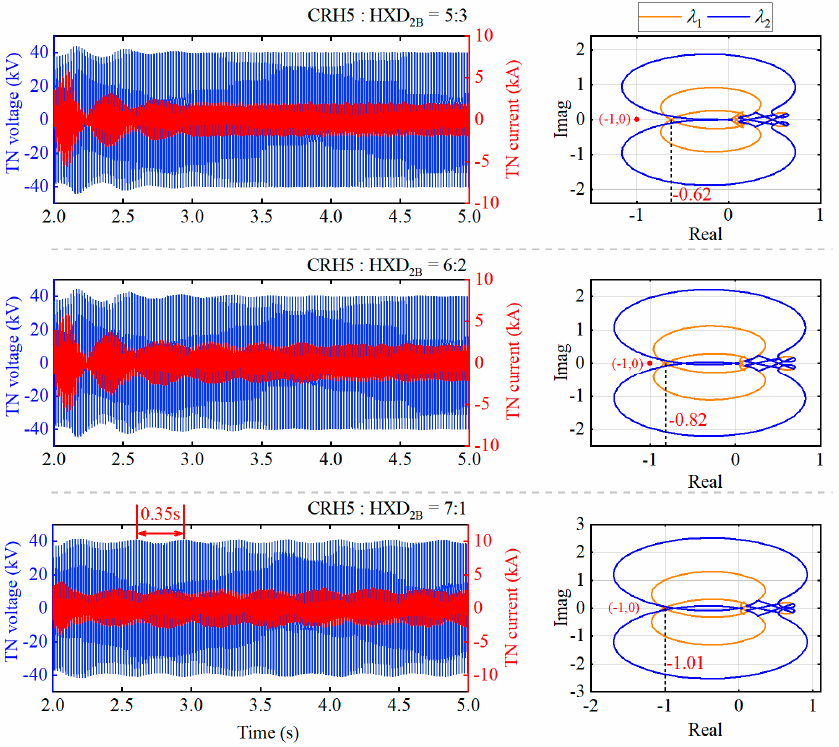
Figure 9. Simulation waveforms when the proportion of passenger and freight locomotives is changed.